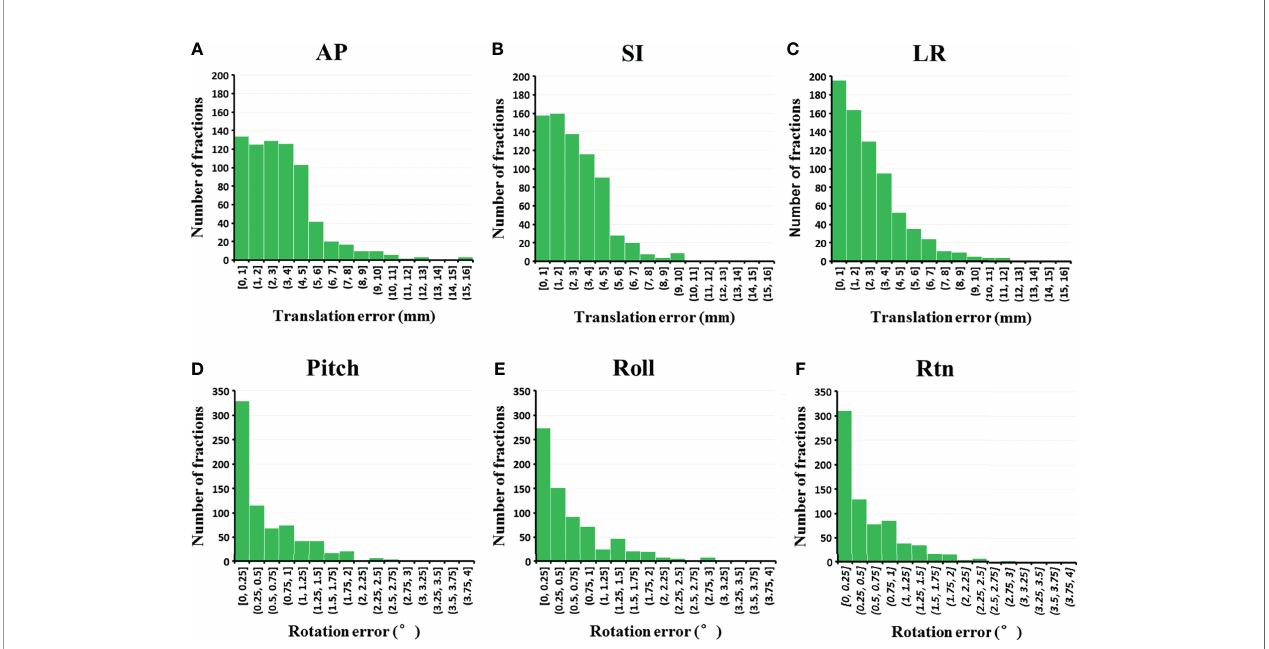
FIGURE 3 | Distribution of the interfraction setup errors in (A) AP, (B) SI, (C) LR, (D) pitch, (E) roll and (F) rtn direction (n = 732 fractions). AP, anterior-posterior; LR, left-right.